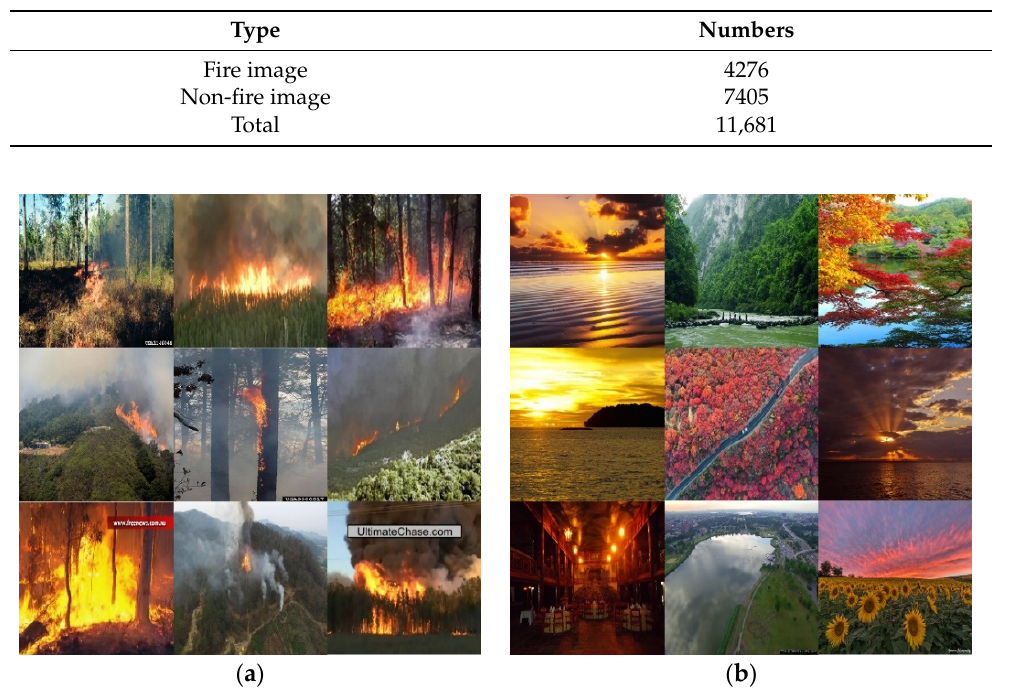
Table 1. Overview of the forest fire dataset.